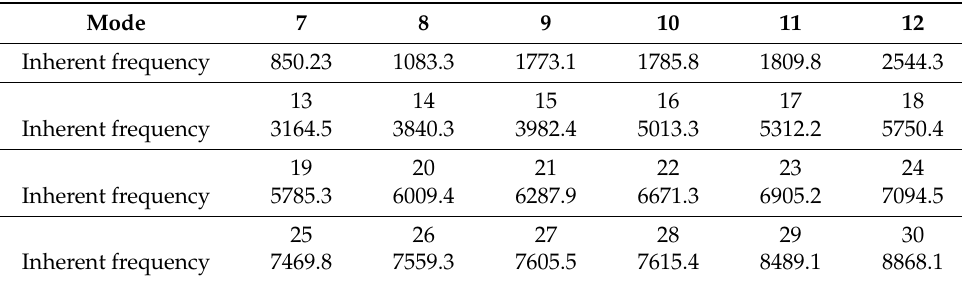
Table 3. Intrinsic frequency in the di ff erent modes. Figure 4. Crankshaft meshing results.